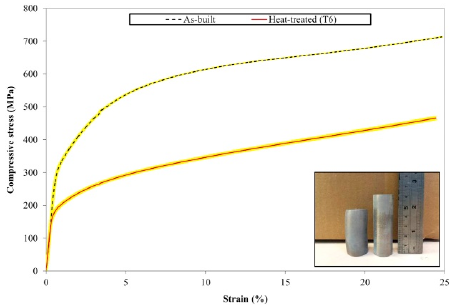
Figure 63. Compressive behavior of as-prepared AlSi10Mg SLM samples with and without annealing treatment. The curves are average of three experimental data sets and the standard deviation is highlighted in yellow. The inset in the figure shows AlSi10Mg sample before and after